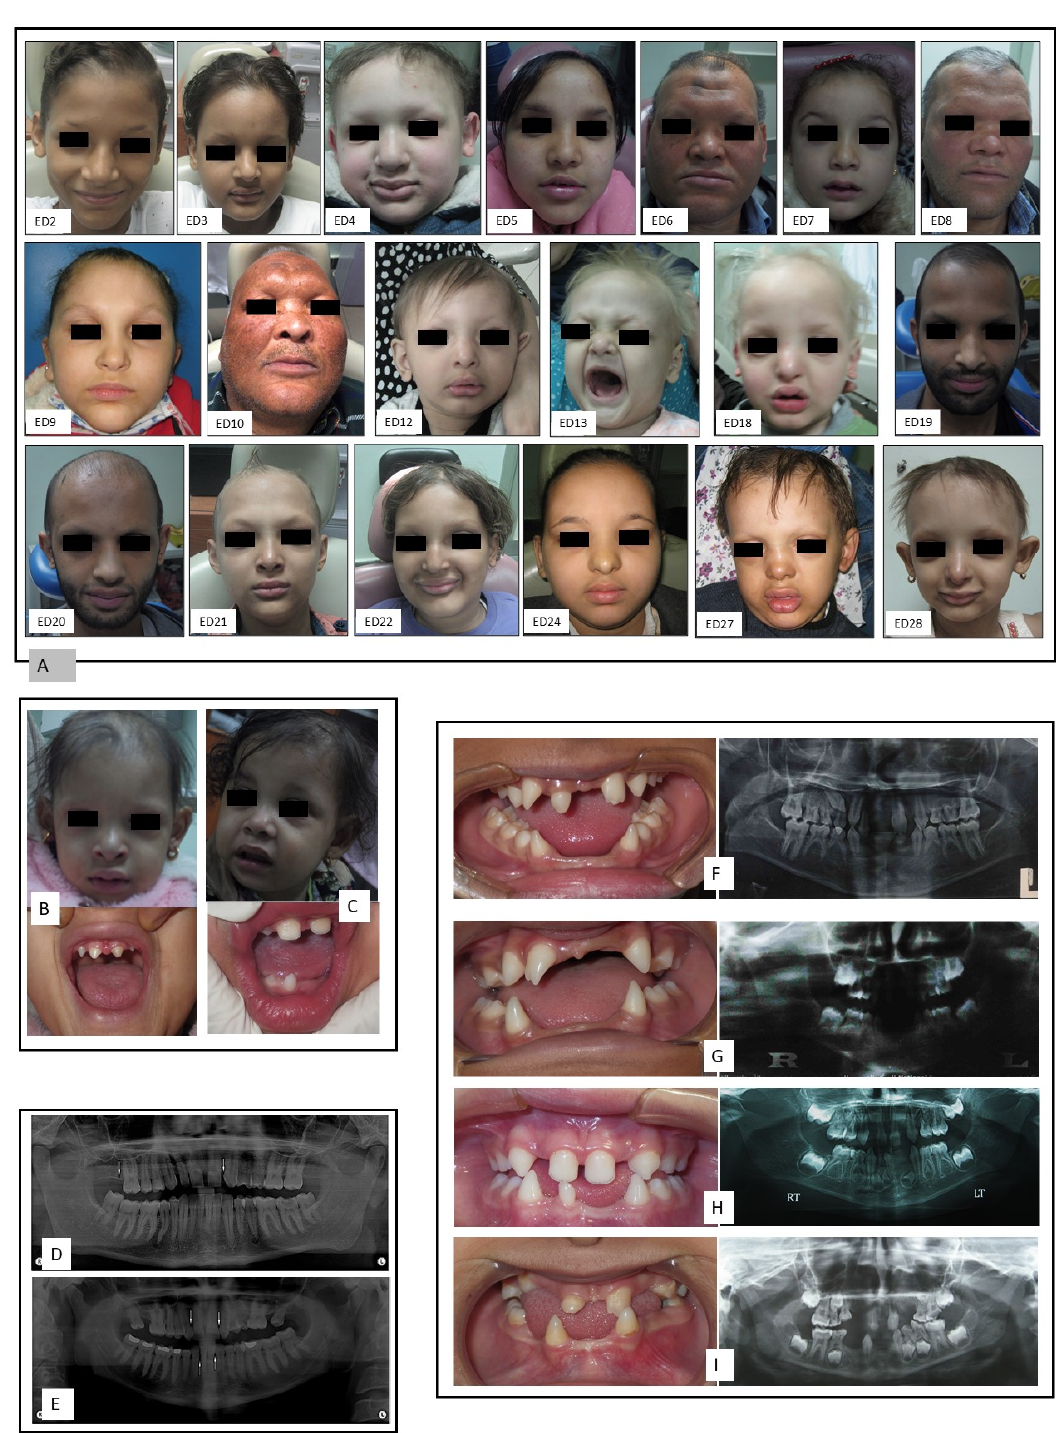
Figure 2. Clinical features and panoramic radiographs of ED patients. ( A ) Facial photographs of ED patients showing the typical facial features of ED, including sparse hair, thick prominent lips, and depressed nasal bridge. ( B , C ) Facial and intraoral photographs of ED14 and ED15, respectively, showing the difference between the severely affected ED14 in contrast to milder phenotype of her sister, ED15 of family 8. ( D , E ) panoramic radiographs of the father and mother of ED28, respectively, showing hypodontia (white arrows indicate sites of missing teeth), which is the only ectodermal feature in these carrier parents, in contrast to the severely affected proband, who showed hypohidrosis, sparse hair without any erupted teeth at the age of 3 years. ( F – I ) Intraoral photographs and panoramic radiographs of patients ED2, ED3, ED7, and ED24, respectively, showing oligodontia and peg shaped